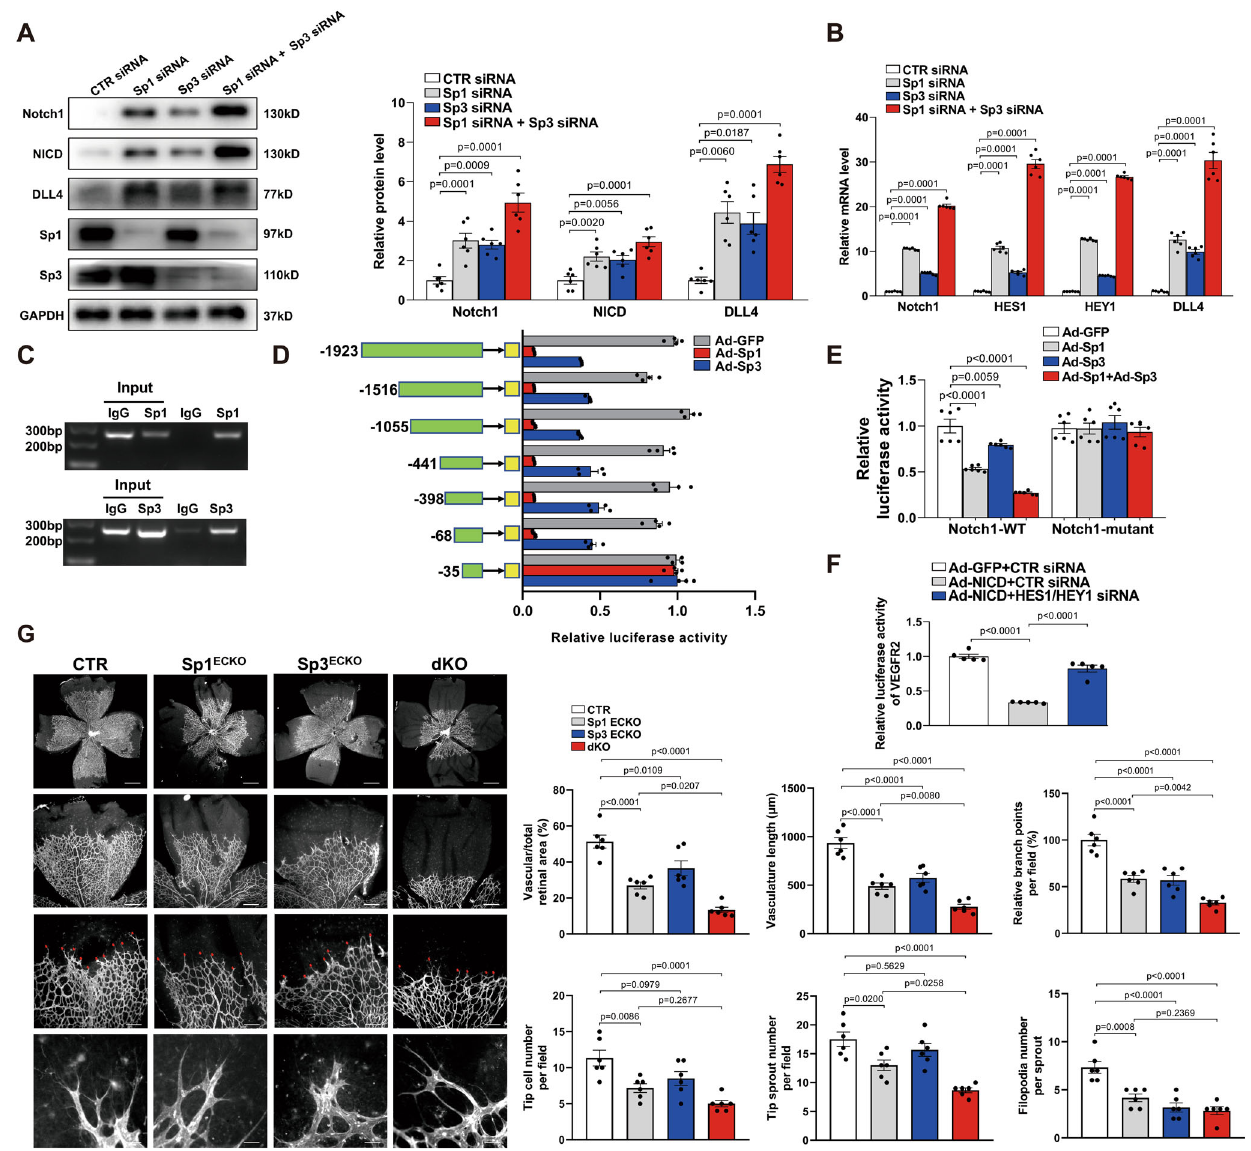
Fig. 8 | Sp3 enhances Sp1-mediated transcriptional repression activity of NOTCH1 in ECs. A Western blot analysis of Notch1, NICD, DLL4, Sp1, and Sp3 protein levels in HUVECs transfected with CTR, Sp1, Sp3, or Sp1+Sp3 siRNA. n =6. B qPCR analysis of NOTCH1, HES1, HEY1, and DLL4 mRNA levels in HUVECs trans- fected with siRNAs for CTR, Sp1, Sp3, or Sp1+Sp3. n =6. C Chromatin immuno- precipitation (ChIP) assay showing the binding of Sp1 or Sp3 to the NOTCH1 promoter in HUVECs. D Relative luciferase activity was shown by the indicated serial promoter deletions of NOTCH1 in HEK293T cells infected with Ad-GFP, Ad- Sp1, or Ad-Sp3. n =6. E Relative luciferase activity of wild-type (NOTCH1-WT) and mutant constructs (NOTCH1-mutant) of the NOTCH1 promoter in HEK293T cells